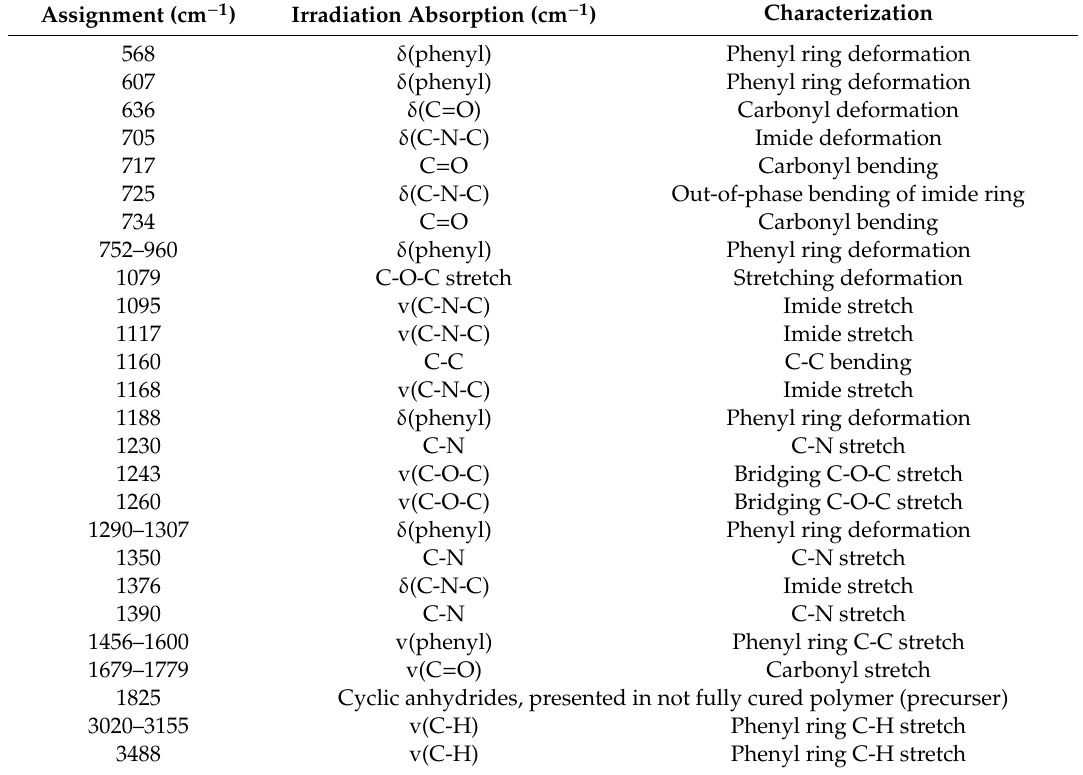
Table 1. Vibrational assignments of